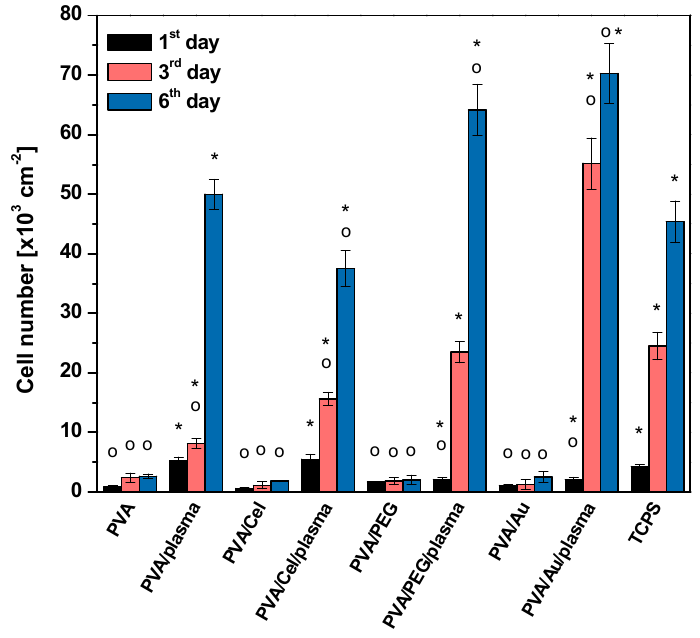
Figure 5. Number of human ASCs after initial adhesion (1st day) and subsequent proliferation (3rd and 6th day) on untreated and plasma-treated PVA foils either non-doped or doped with cellulose (Cel), with poly(ethylene glycol) (PEG) or with Au nanoparticles in a PEG colloid solution (Au), and on the control tissue culture polystyrene (TCPS). Statistical significance p ≤ 0.0001 in comparison with TCPS (o) or the pristine PVA samples (*) is expressed using the ANOVA method (data were used from 40 images for each experimental group).